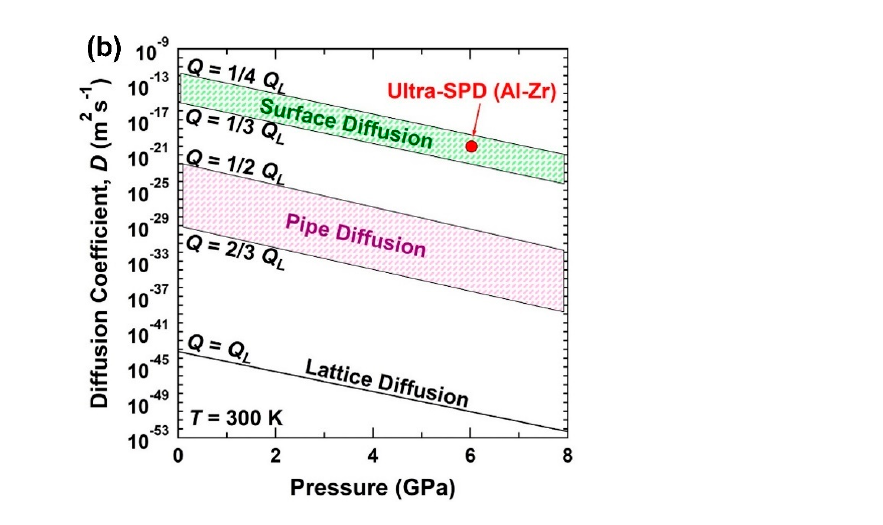
Figure 1. Ultra-fast diffusion during ultra-SPD. Estimated diffusion coefficients during ultra-SPD processing via HPT (red circles) for ( a ) Al-Cu alloy plotted against Cu content and ( b ) Al-Zr alloy plotted against pressure in comparison with the reference data calculated using activation energy for lattice diffusion Q L , grain boundary diffusion (1/2–2/3) Q L , and surface diffusion (1/4–1/3) Q L [24,26].